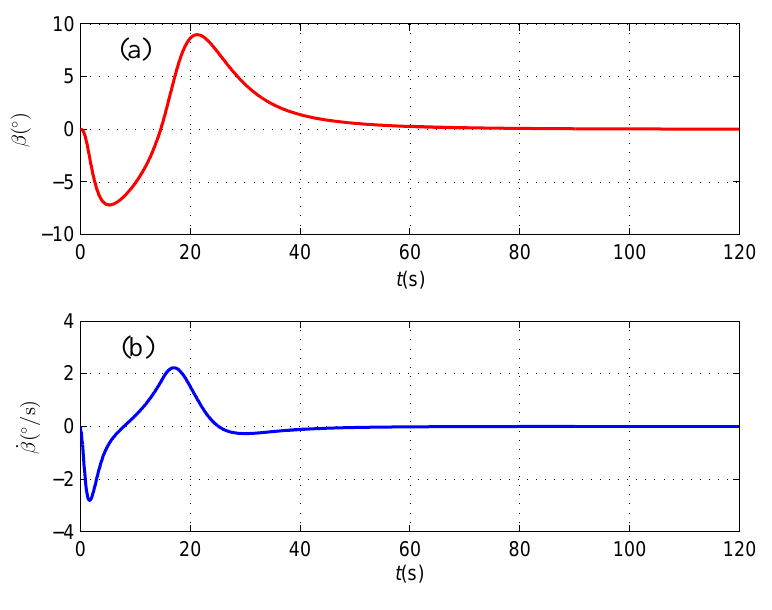
Figure 12. ( a ) Side-slip angle β ; and ( b ) The derivative of the side-slip angle ˙ β .